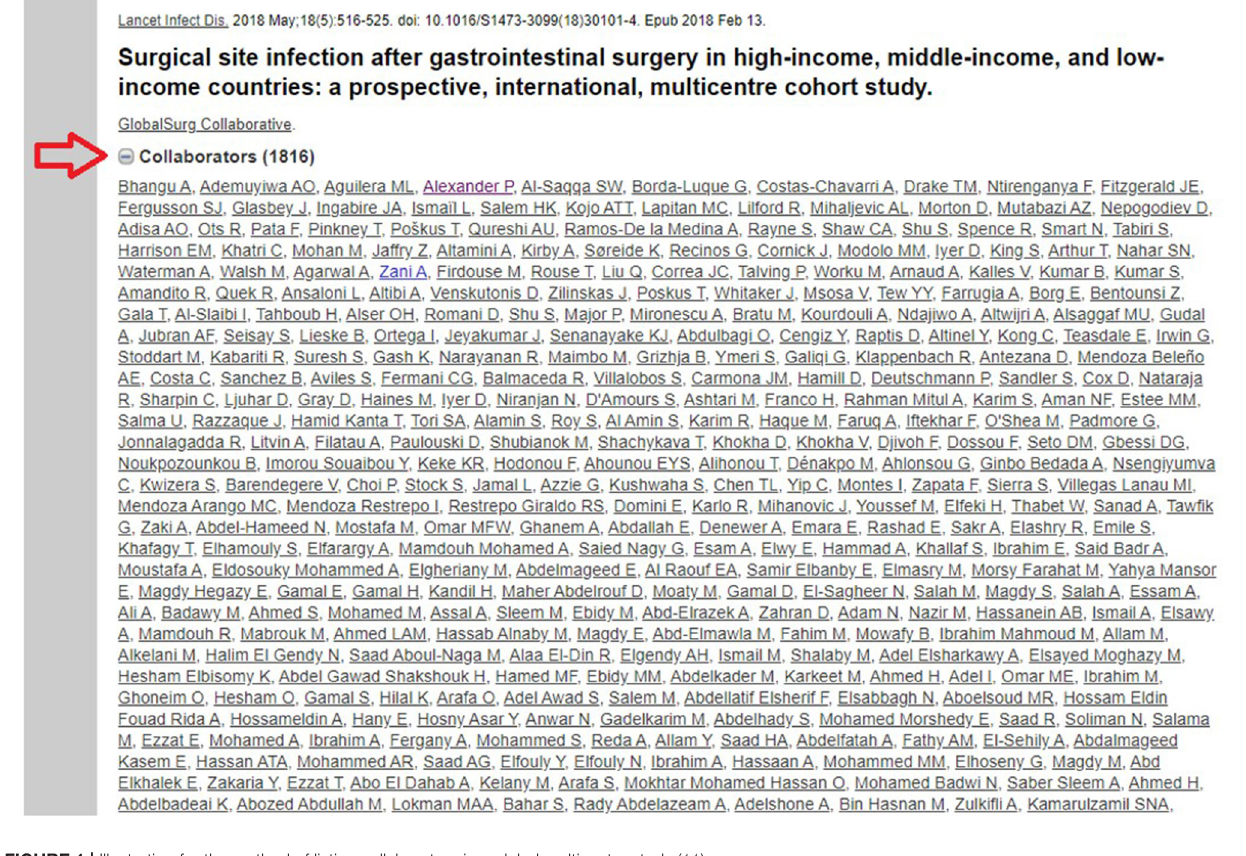
FIGURE 1 | Illustration for the method of listing collaborators in a global multicentre study (11).